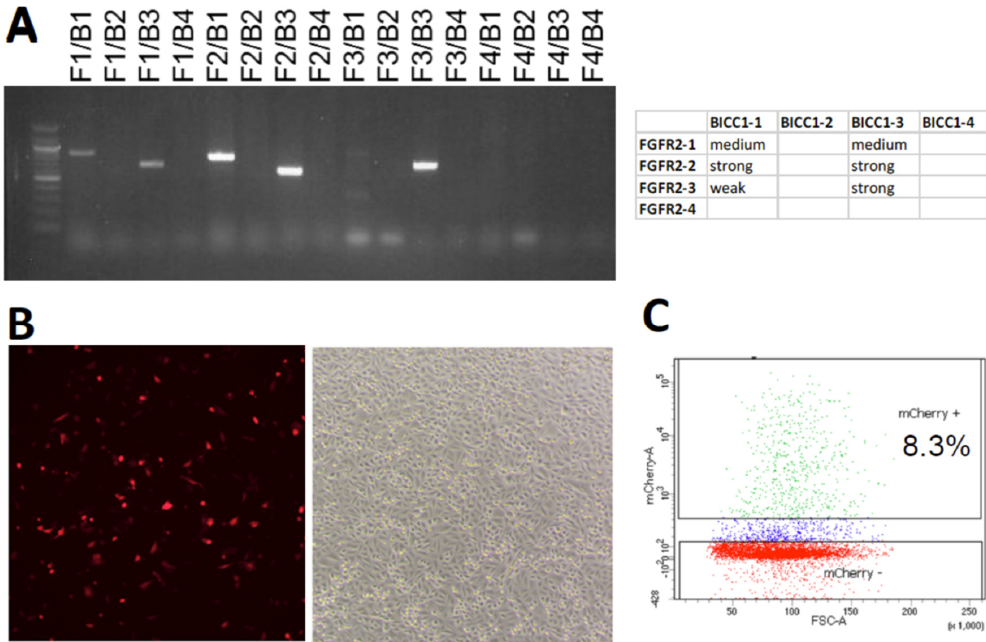
Figure 2. Discovery of sgRNA combinations that induce the FGFR2–BICC1 fusion. ( A ) Detection of FGFR2–BICC1 gene fusions using PCR after cells were transiently transfected with the two-plasmid system. ( B ) mCherry positivity ( left ) indicating transfection efficiency of cells (brightfield, right ) transfected with the two-plasmid system 48 h after transfection. Magnification = 4×. ( C ) Representative FACS data of transfected cells 48h after transfection.